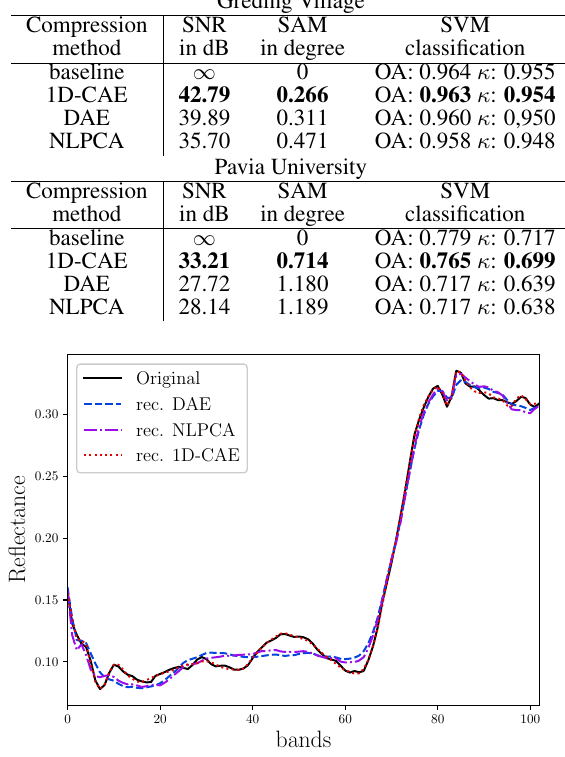
Table 2. Comparison of the different compression methods based on SNR, SAM, and land cover classification. The baseline in the second row indicates the hypothetical results for a perfect (loss-less) reconstruction. A high SNR value and a small spectral angle indicate a good reconstruction accuracy of the original data. The best values for each metric are highlighted in bold.